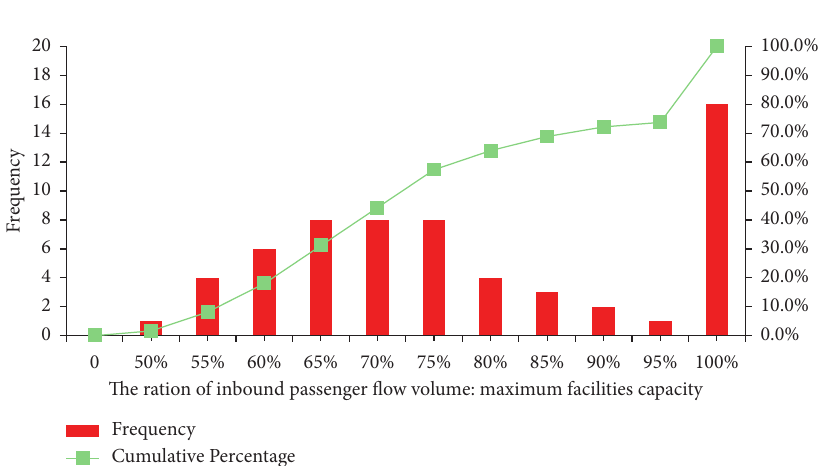
Figure 5: Statistics on the utilization of the station inbound capacity under coordinated inflow control